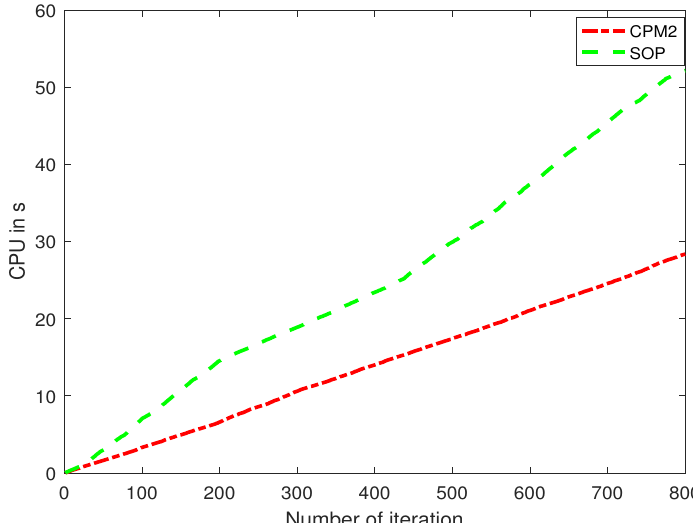
Figure 4. The comparison of the CPU time of the CPM and SOP for ( m , n ) = (1000, 2000) of Example